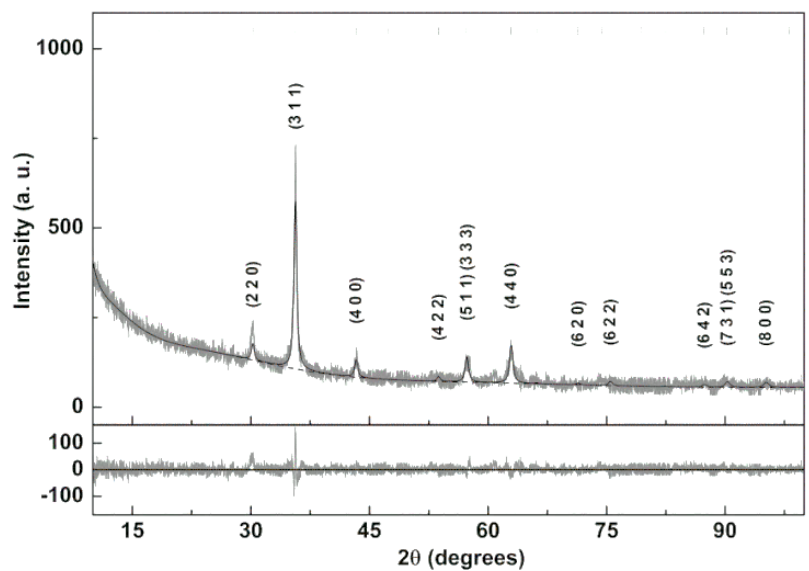
Figure 2. XRD pattern of the Ca 0.25 Mg 0.75 Fe 2 O 4 nanoparticles and corresponding Rietveld analysis.